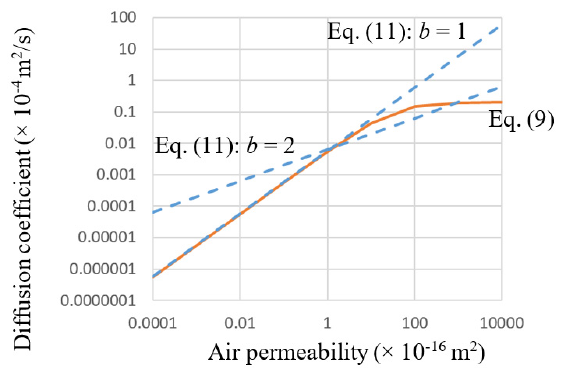
Figure 2 . Relationship between the air diffusivity and air permeability described by Eqs. (6), (7), and (9).